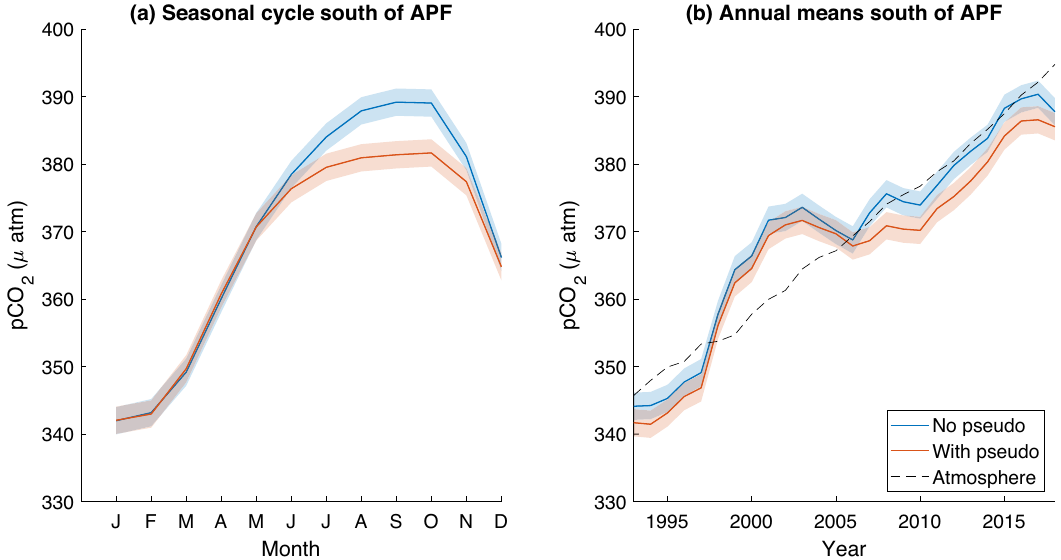
Fig. 2 Mean pCO 2 from SOM-FFN reconstructions. a 1993-2018 mean seasonal cycle and b annual mean surface pCO 2 (in micro-atmosphere, µ atm) south of the Antarctic Polar Front from the SOM-FFN with and without pseudo observations in the training data (solid lines). Each line represents an ensemble mean, and the shaded areas are the 1- σ uncertainties (see Methods section). The black dashed line shows the annual mean atmospheric pCO 2 above the same ocean area, calculated from the NOAA ESRL product 50,51